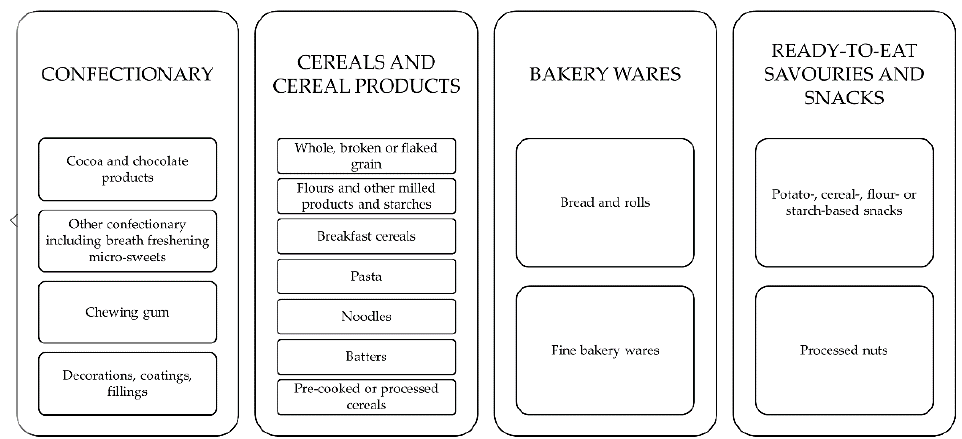
Figure 3. Representation of the followed product categorization. Adapted from [59].